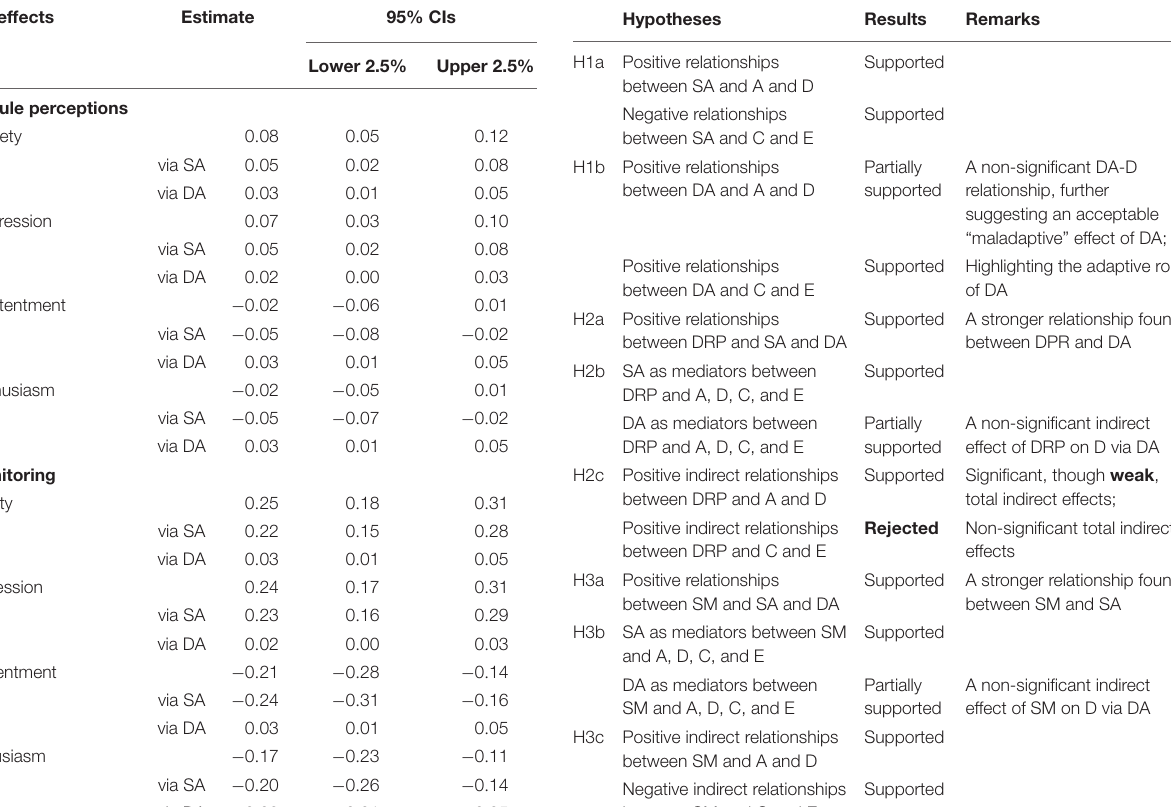
TABLE 3 | The estimates of indirect effects and the 95% confidence intervals. TABLE 4 | A summary of the hypotheses and